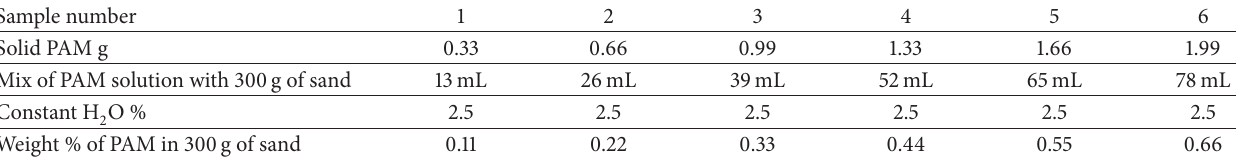
Table 2: Composition of six polymer-sand composite samples with different weight % of the polymer.